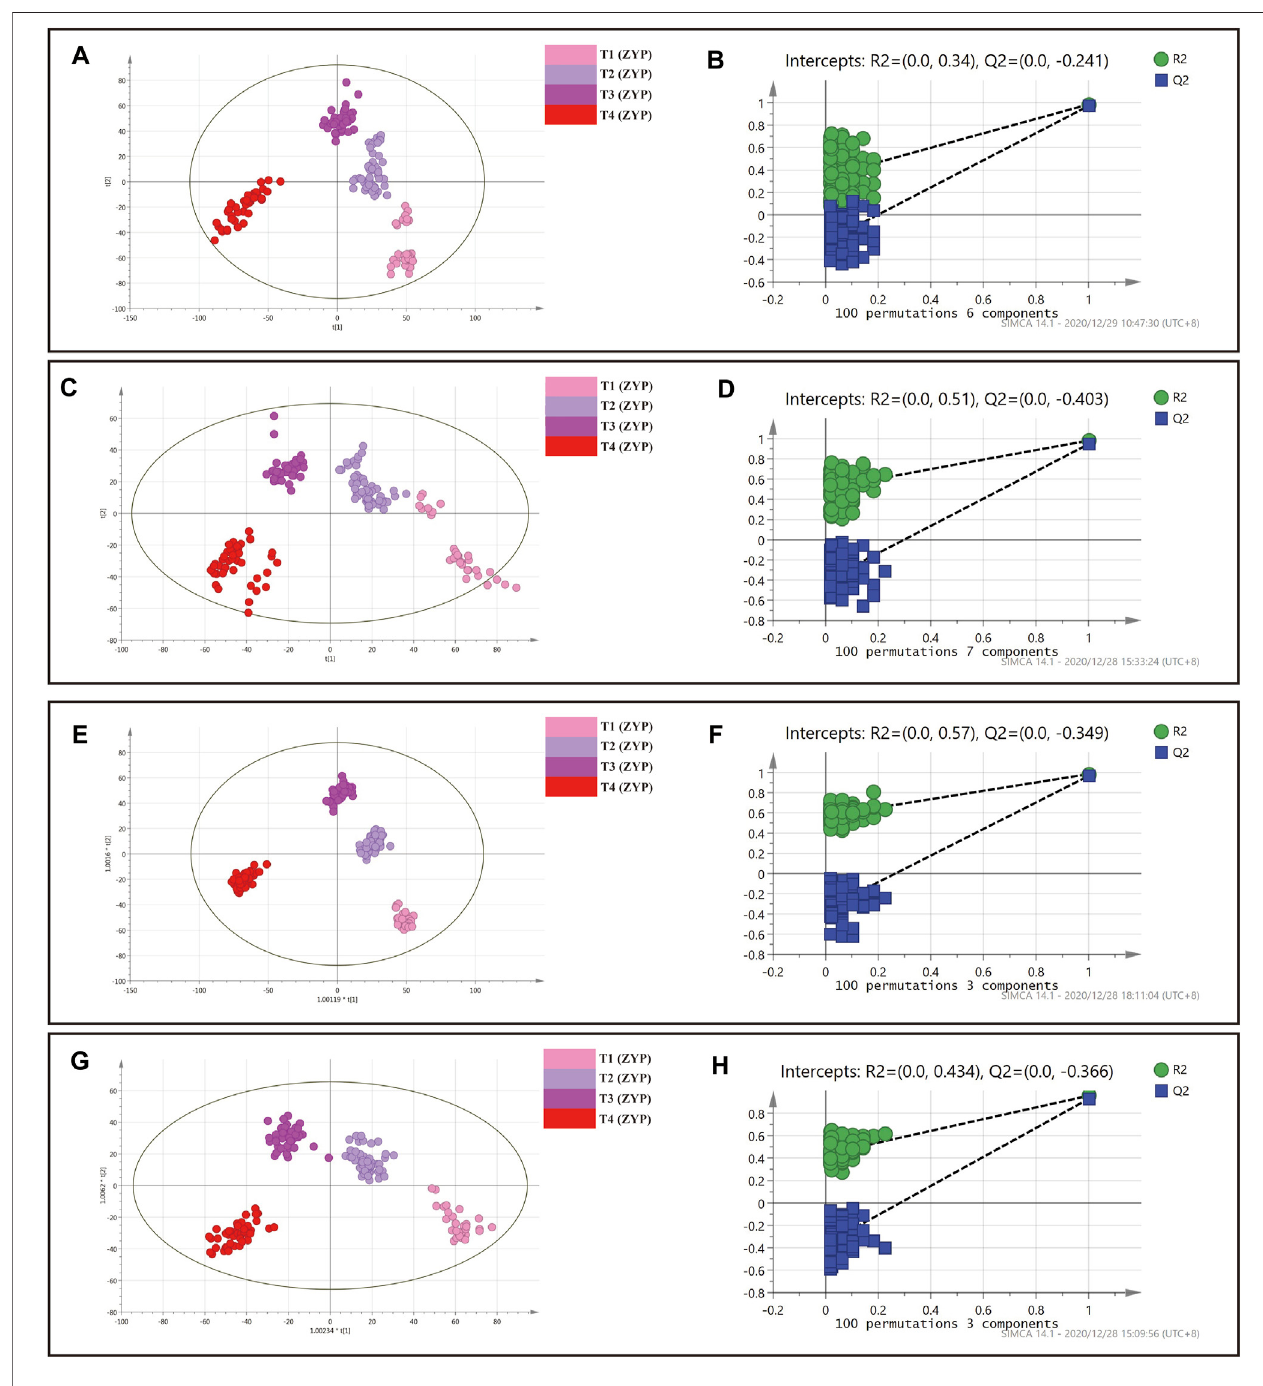
FIGURE 5 | PLS-DA and OPLS-DA analysis on plasma samples in ZYP group. (A) PLS-DA analysis in positive mode. (B) Permutation test of PLS-DA analysis in positive mode. (C) PLS-DA analysis in negative mode. (D) Permutation test of PLS-DA analysis in negative mode. (E) OPLS-DA analysis in positive mode. (F) Permutation test of OPLS-DA analysis in positive mode. (G) OPLS-DA analysis in negative mode. (H) Permutation test of OPLS-DA analysis in negative mode. : T1 (ZYP), : T2 (ZYP), : T3 (ZYP), : T4 (ZYP).